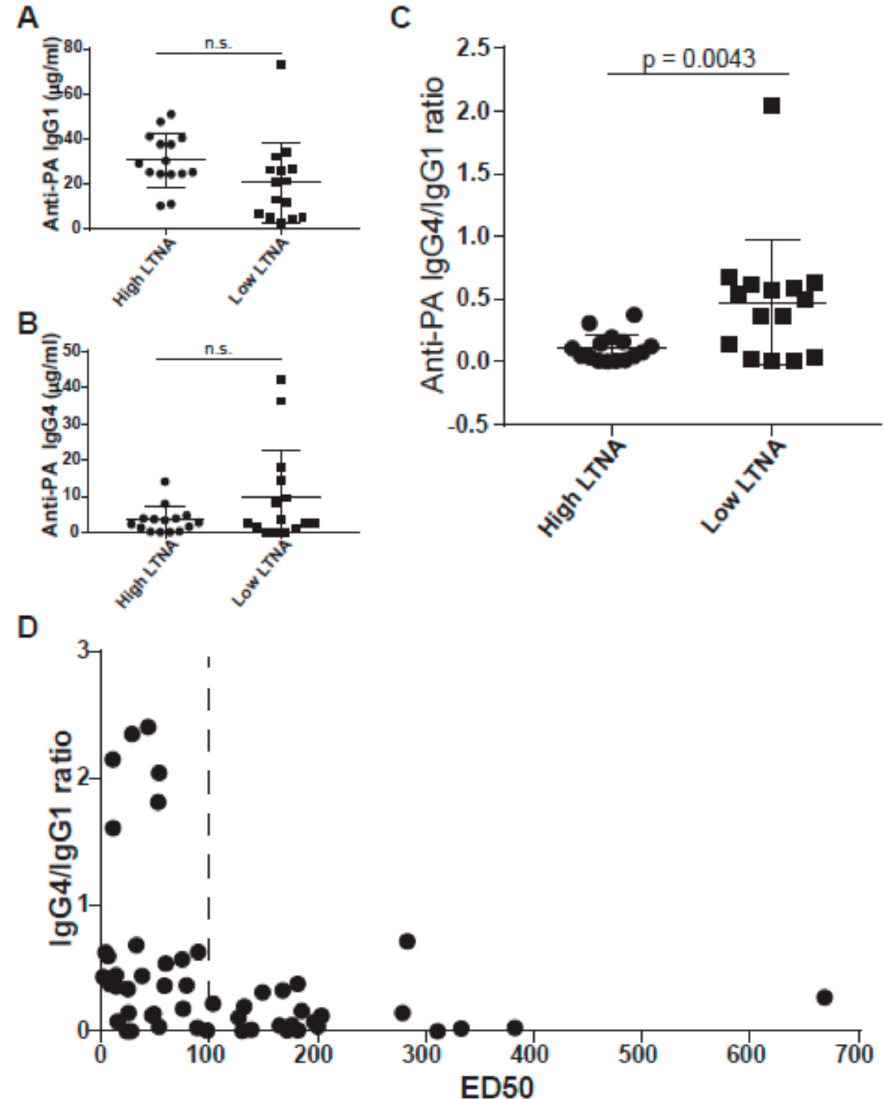
Figure 3. IgG subclass concentrations by ELISA in the matched cohort. ( A ) Anti-PA IgG1 concentrations show a non- significant higher trend in high neutralizers. ( B ) Anti-PA IgG4 concentrations show a non-significant higher trend in low neutralizers. ( C ) Low neutralizers have a significantly higher IgG4/IgG1 ratio. In panels A, B, and C, data from high neutralizers are shown as circles; data from low neutralizers are shown as squares. ( D ) When expanded from 30 individuals to 53 individuals including 23 that have received 8, 9, or 10 vaccinations, a striking subset of 6 individuals with IgG4/IgG1 ratio over 1.0 who are low neutralizers becomes evident.